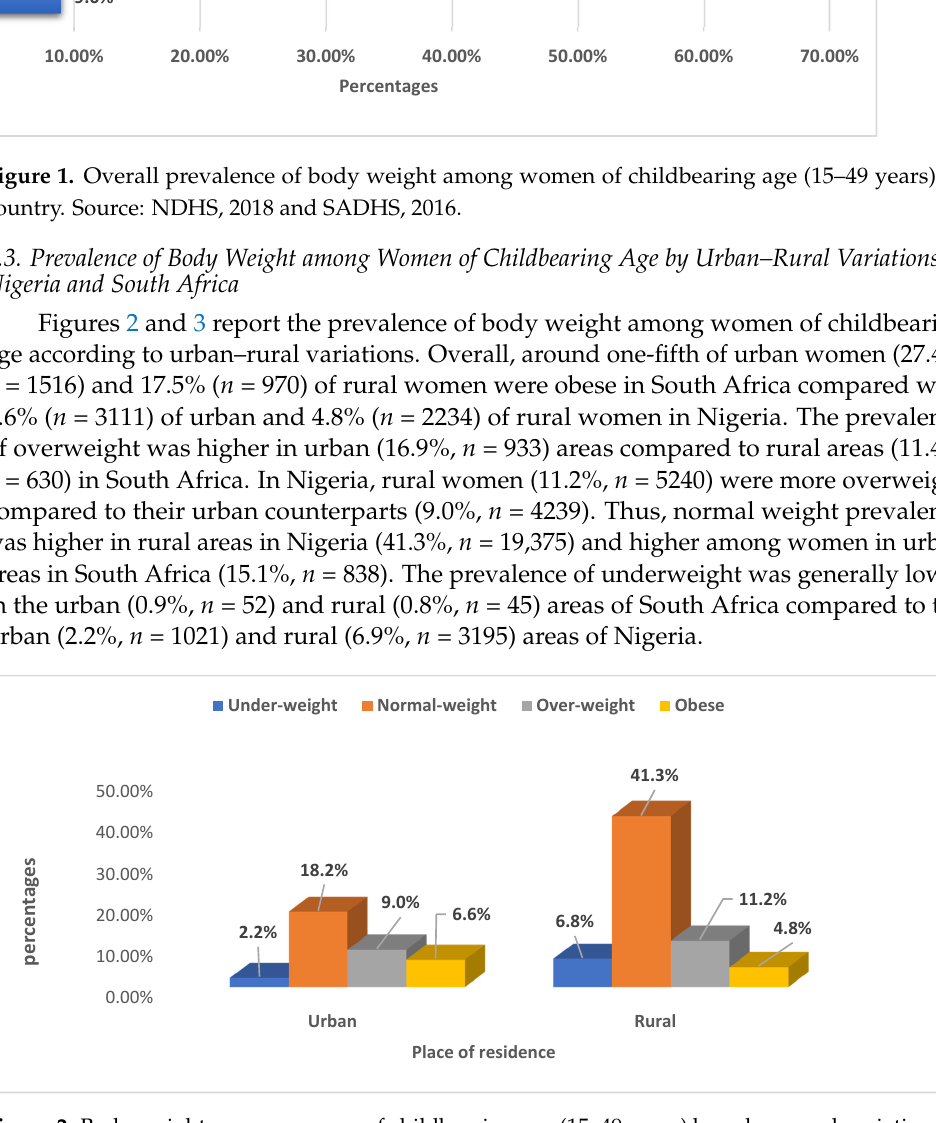
Figure 3. Body weight among women of childbearing age (15–49 years) by urban–rural variations in South Africa. Source: SADHS, 2016. Regarding education, increasing educational status was associated with being over- weight (primary (OR = 1.98, p < 0.001), secondary (OR = 2.36, p < 0.001), and tertiary (OR = 3.43, p < 0.001)) and obese (primary (OR = 2.76, p < 0.001), secondary (OR = 3.91, p < 0.001), and tertiary (OR = 7.30, p < 0.001)). Furthermore, for employment status in Nigeria, self- employed respondents were found to be associated with underweight (OR = 1.49, p < 0.001), while self-employed (OR = 4.70, p < 0.01) and employed (OR = 9.02, p < 0.001) re- spondents were found to be associated with obesity (Table 3). Moreover, increasing wealth index was found to be associated with overweight and obesity, while currently widowed and divorced/separated women were found to be associated with obesity in ur- ban–rural areas. Similarly, women from the North east and North west were found to be associated with underweight, while those from the South south and South west were more likely to be associated with overweight and obesity among urban and rural women (Table 3). Women with seven or more children were more likely to be associated with under- weight, while women with four to six children were more likely to be associated with